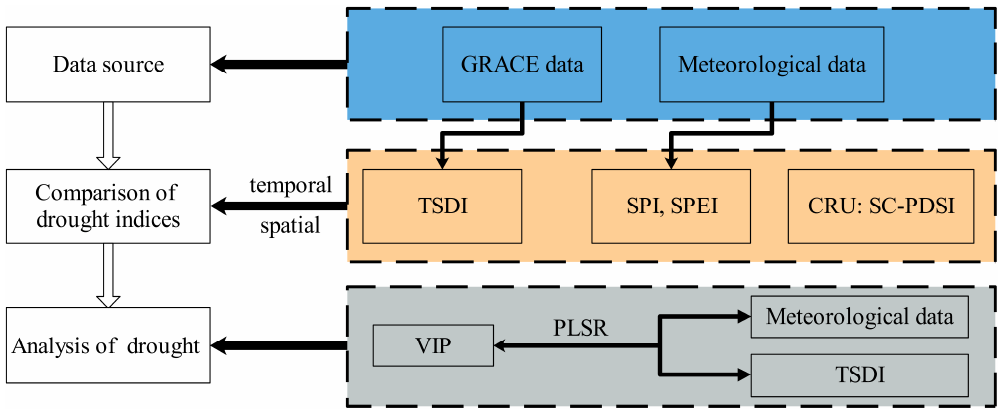
Figure 2. Flowchart of the drought monitoring and